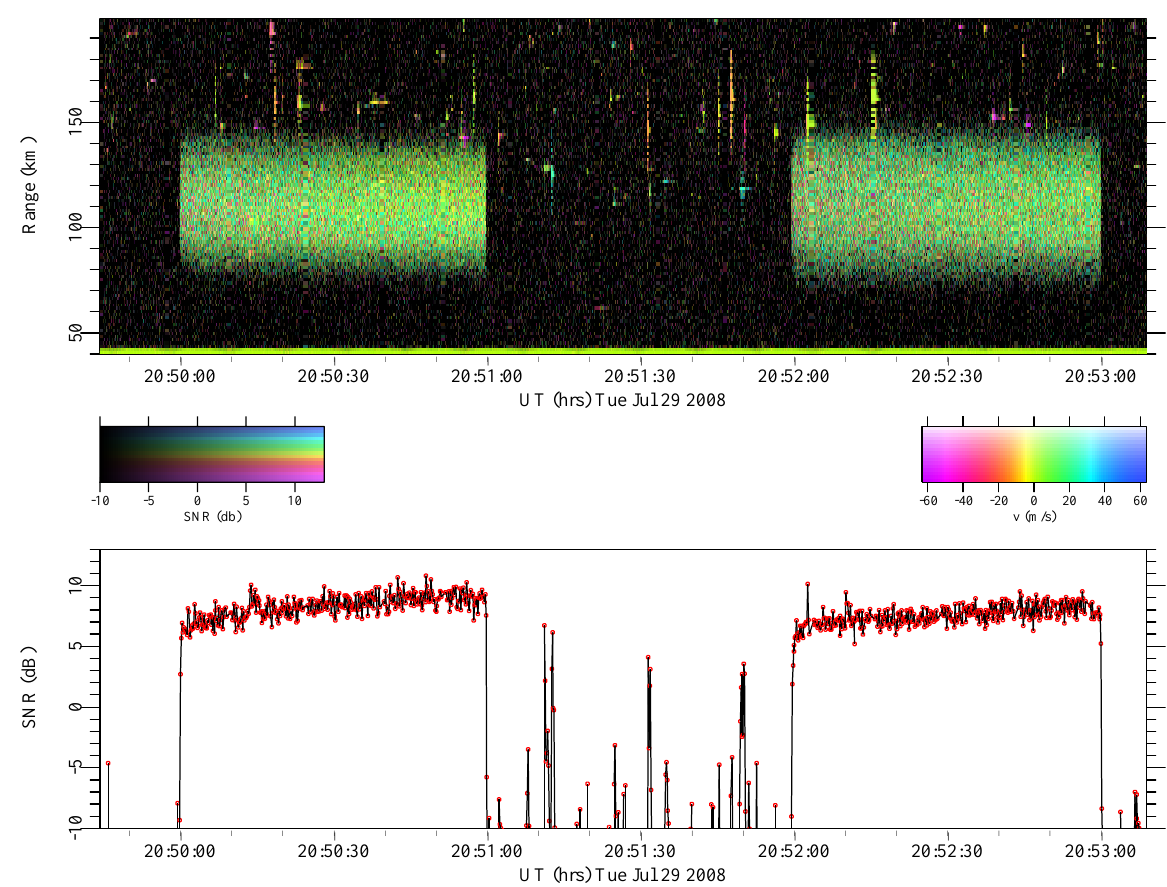
Fig. 2. RTDI plot of backscatter from artificial E region FAIs over HAARP observed on 29 July 2008. The incoherent integration time for the figure is about 0.158 s.